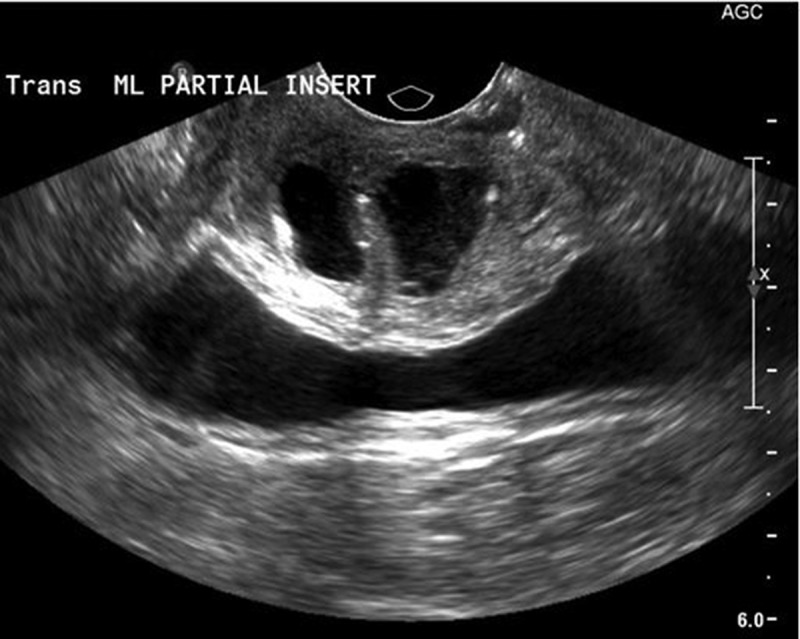
Transvaginal US of a 2.3-cm saddlebag UD.